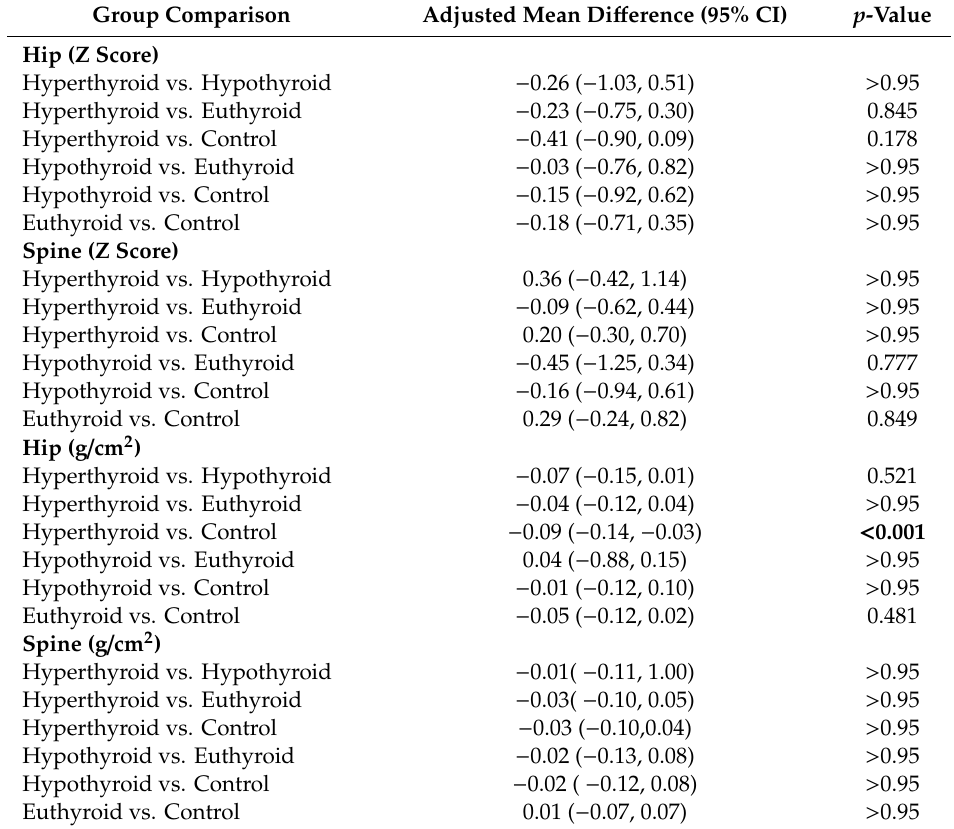
Table 15. Pairwise comparison of Z score and bone density (g / cm 2 ) of hip and spine among groups adjust for age and gender